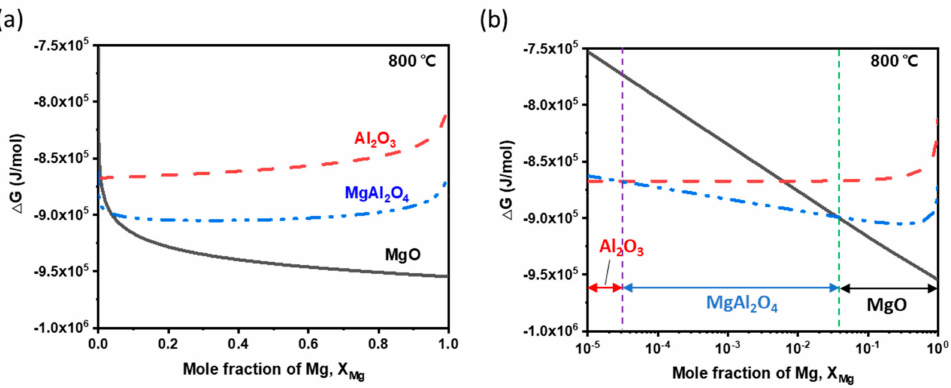
Figure 10. Gibbs free energy profiles of oxides Al 2 O 3 , MgAl 2 O 4 and MgO at 800 ◦ C as a function of mole fraction of Mg on ( a ) a linear scale and ( b ) a logarithmic